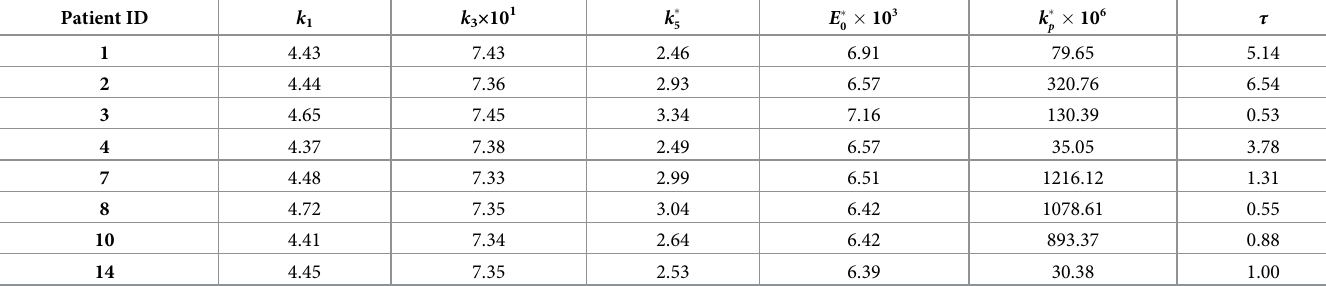
Table 3. Estimated individual parameters of the model fit to the sputum viral load dataset [38] (Fig 2). Units are the same as in Table 2. Patient